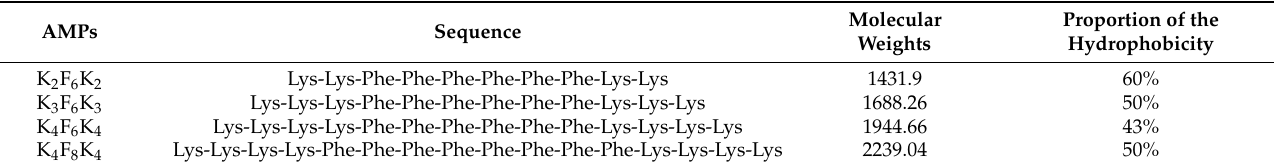
Table 1. The basic properties of K n F m K n